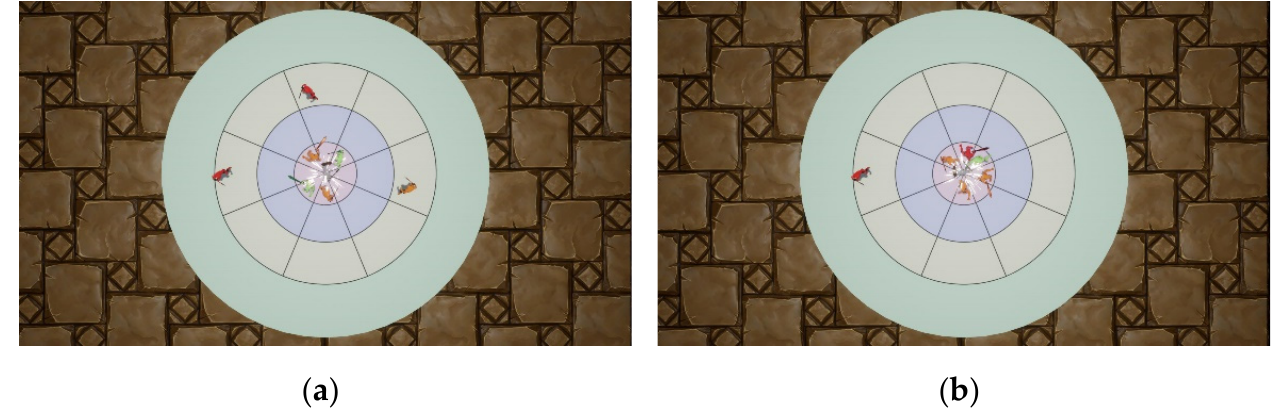
Figure 8. Attack mechanism tests of IBAI. ( a ) The first combat scene; ( b ) The second combat scene.